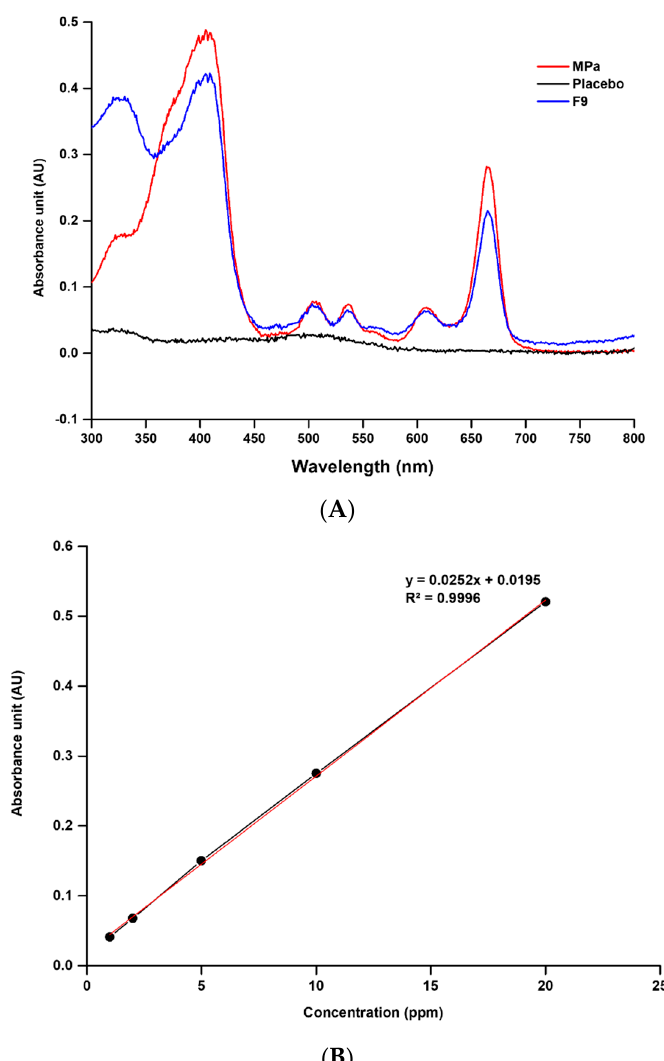
Figure 2. UV-Vis spectra and calibration curve of MPa. ( A ) Specificity data of MPa, placebo, and MPa-loaded nano-transfersome F9 (MeOH, 25 °C). ( B ) Linearity data of MPa standard stock solution in MeOH.